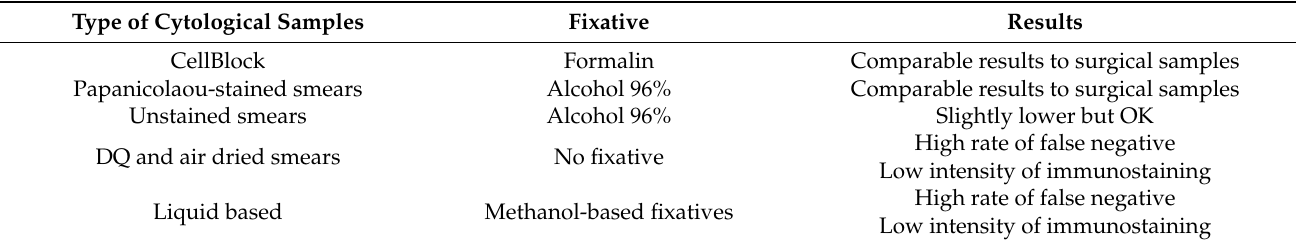
Table 2. Performance of the different types of cytological samples and fixatives. Type of Cytological